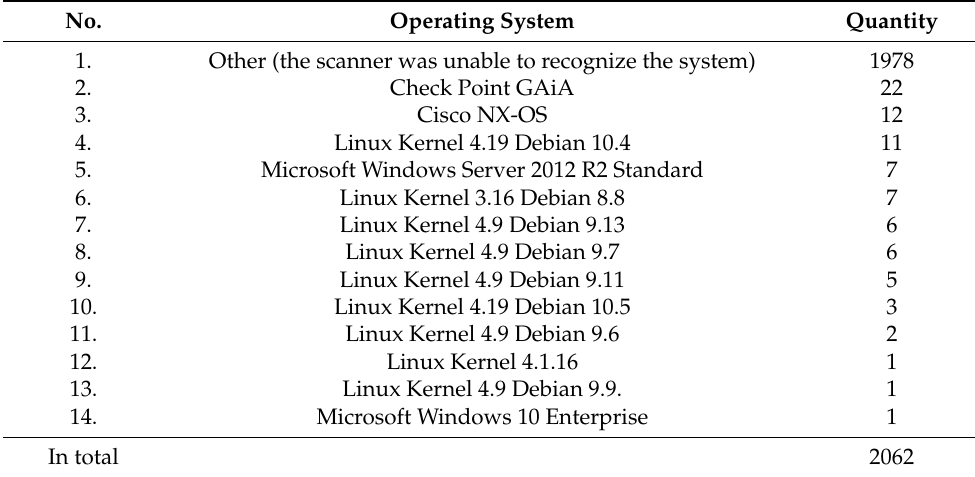
Table 6. Numbers and types of operating systems detected for environment